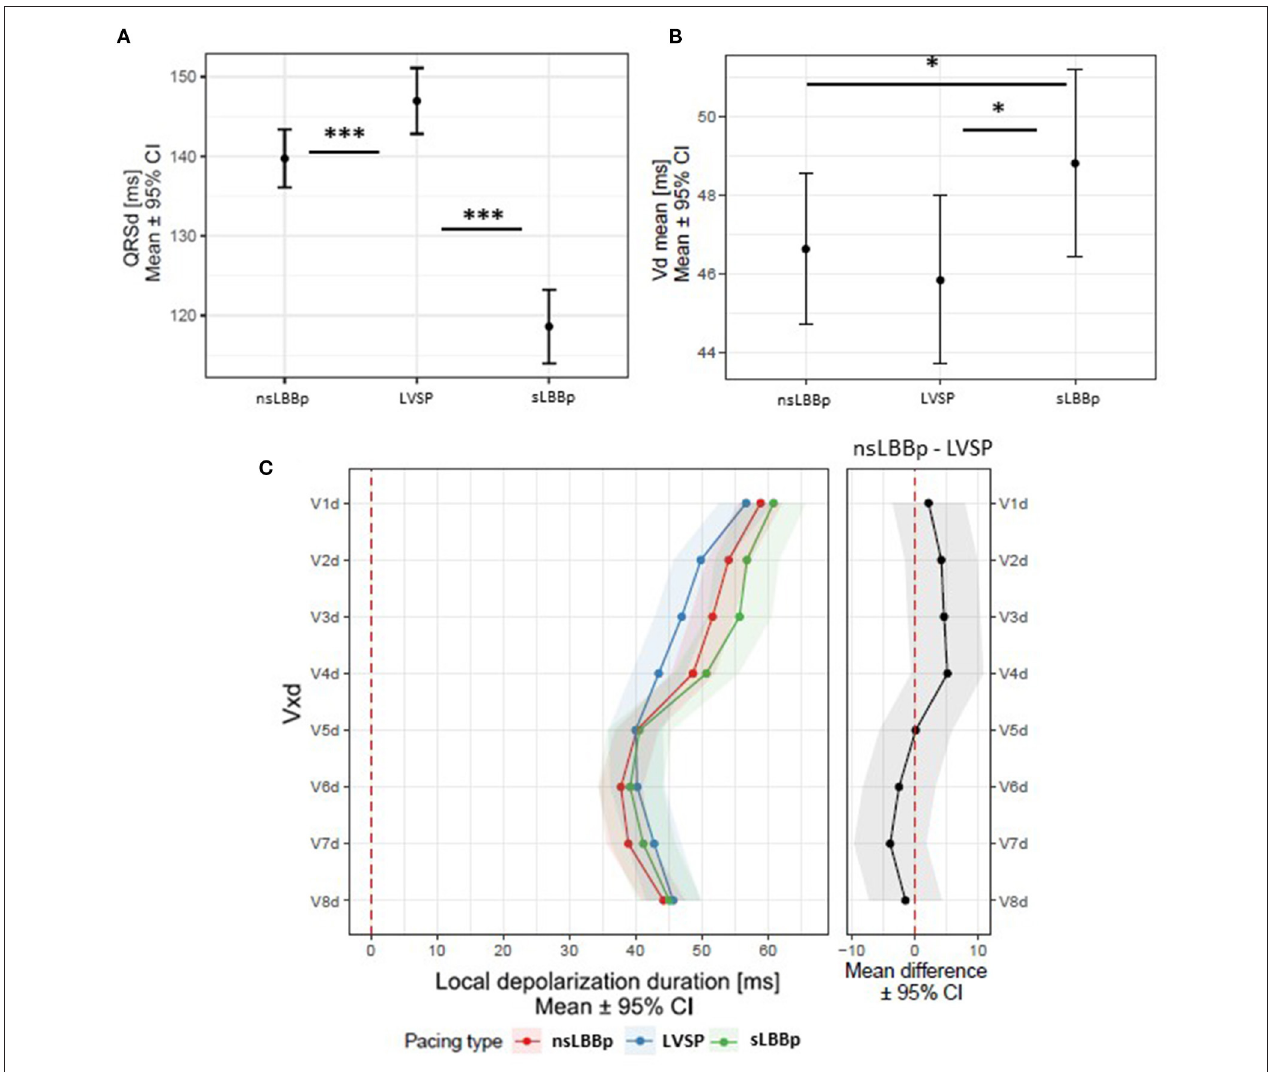
FIGURE 4 | (A) QRSd, Vd mean (B) , and local depolarization durations (Vd in V1–V8) (C) between nsLBBp, LVSP, and sLBBp. * p < 0.05; *** p <